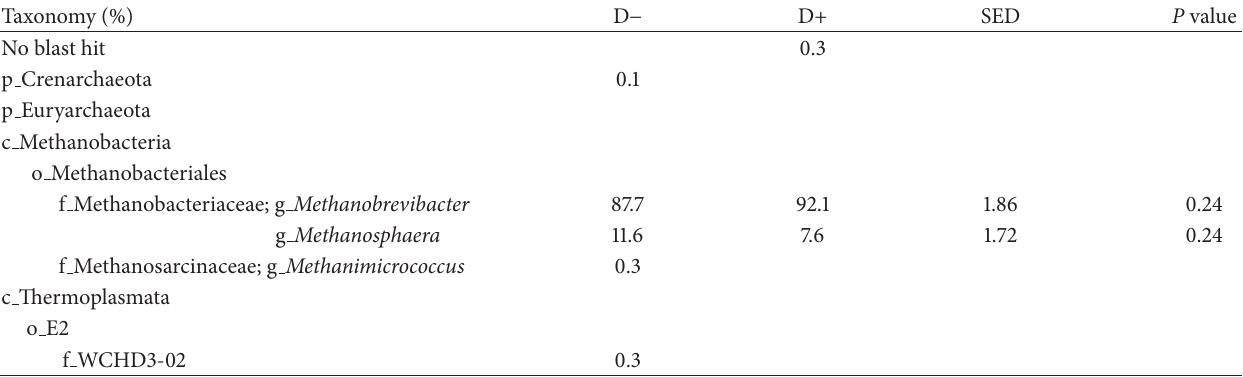
Table 1: Effect of bromochloromethane (BCM) treatment of does on relative abundance (% of total sequences) in the rumen contents at weaning